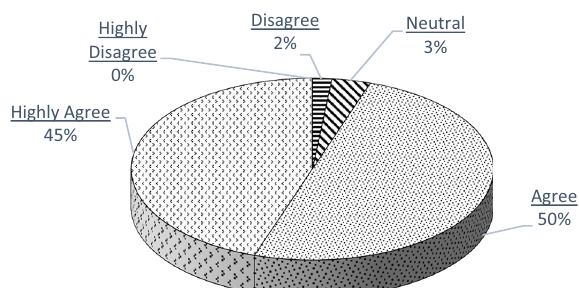
Fig. 3 Summary of results obtained by the ICT professionals